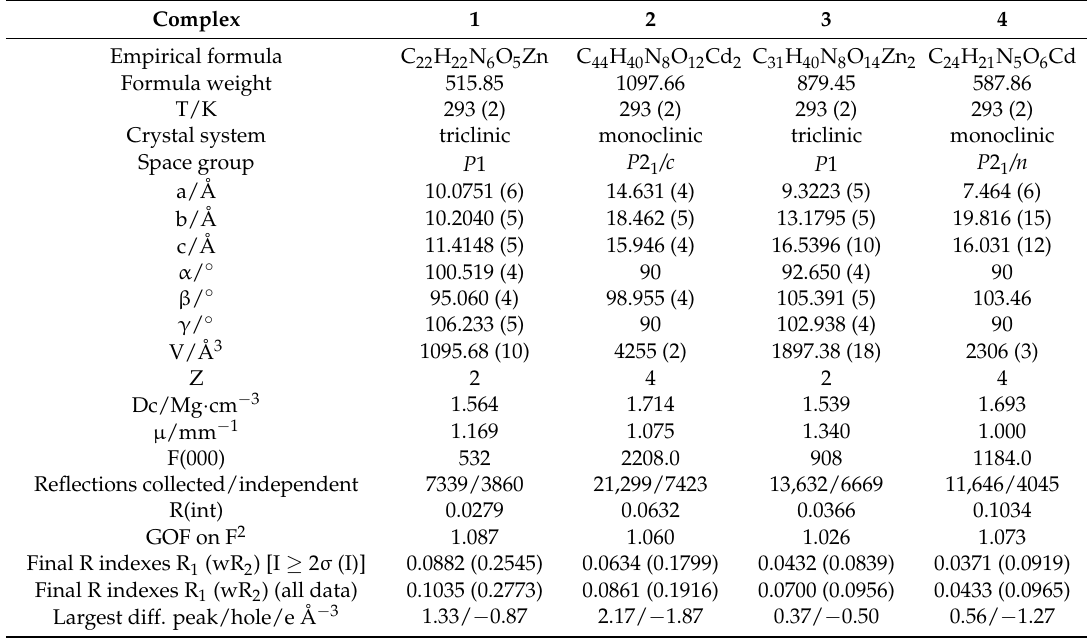
Table 1. Crystallographic date and structure refinement results for complexes 1 – 4